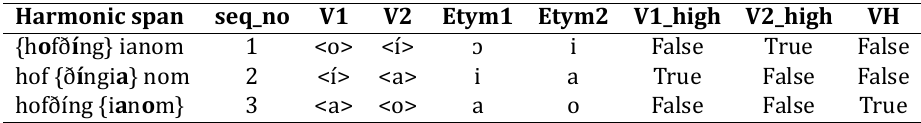
Table 2: Division into pairwise vowel sequences